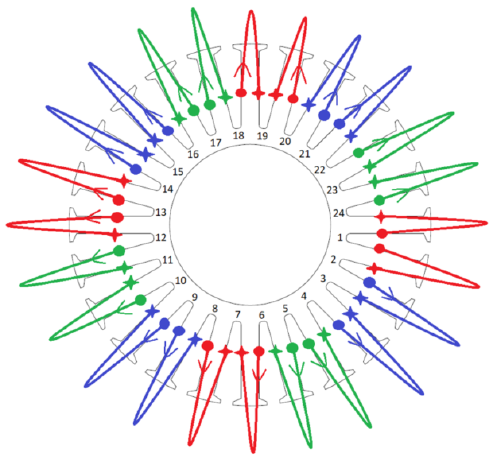
Figure 2. Connection scheme of stator